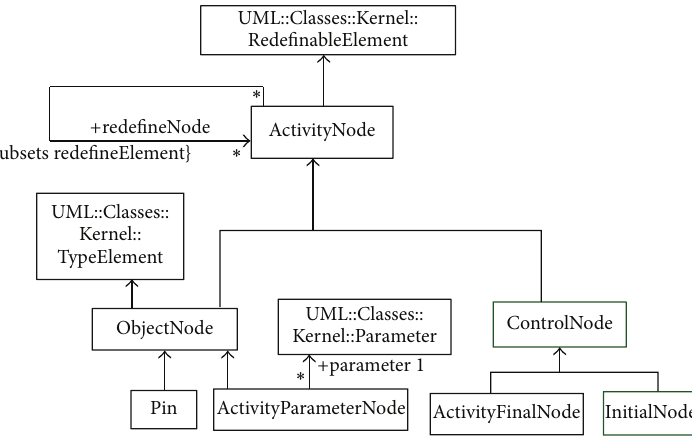
Figure 5: Metamodel of the OMG